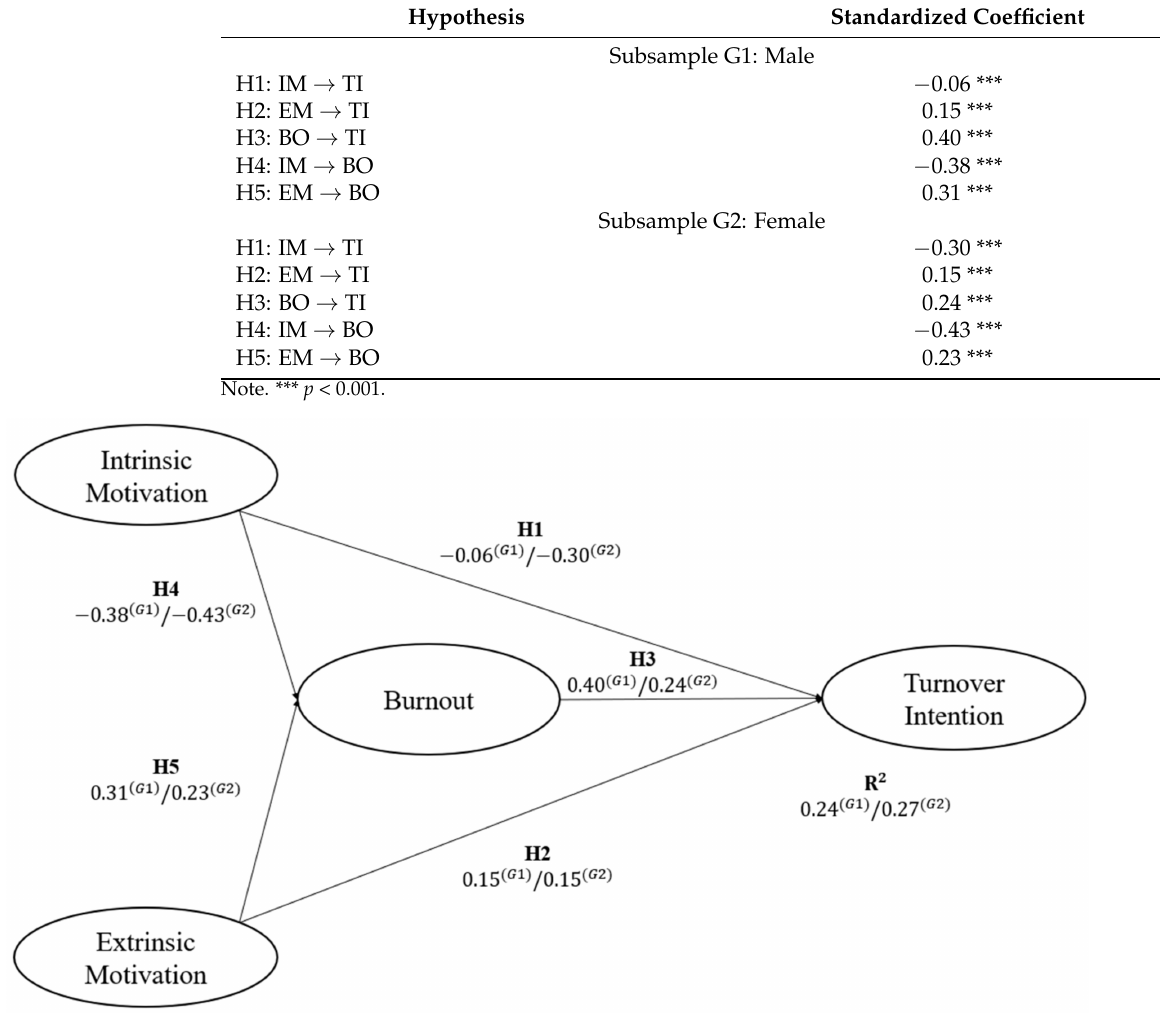
Figure 3. Standardized structural path coefficients for both subsamples. G1: Male ( n = 470); G2: Female ( n = 574).